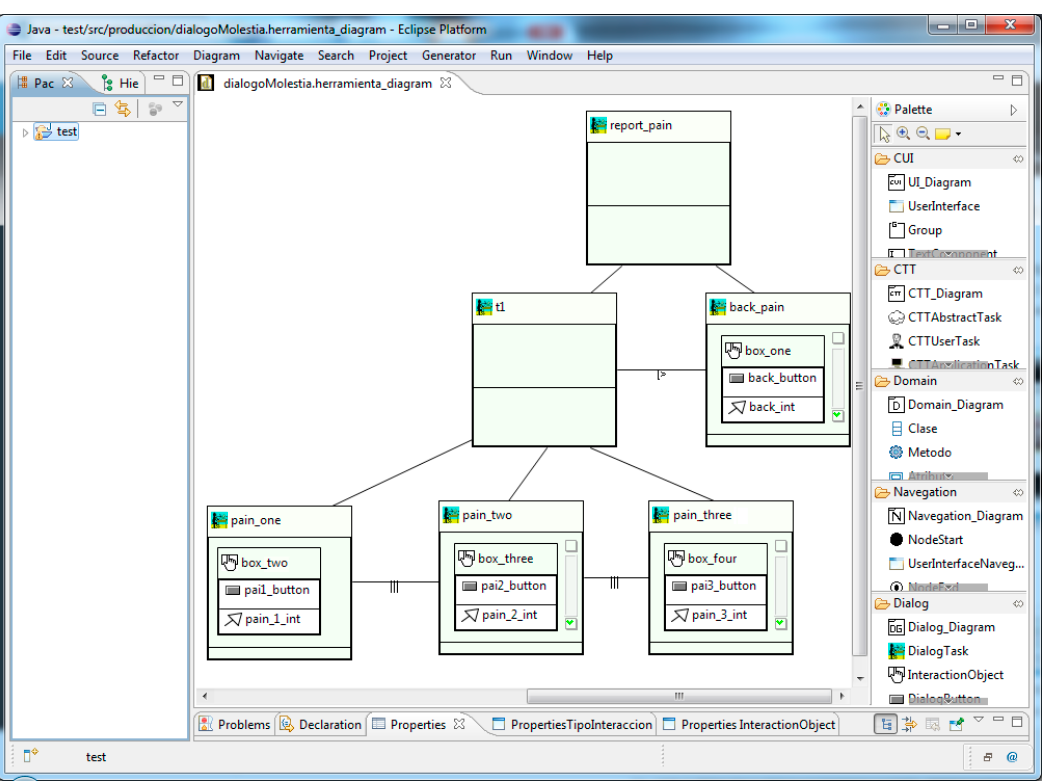
Figure 2. CTT diagram used as input for the Telecare